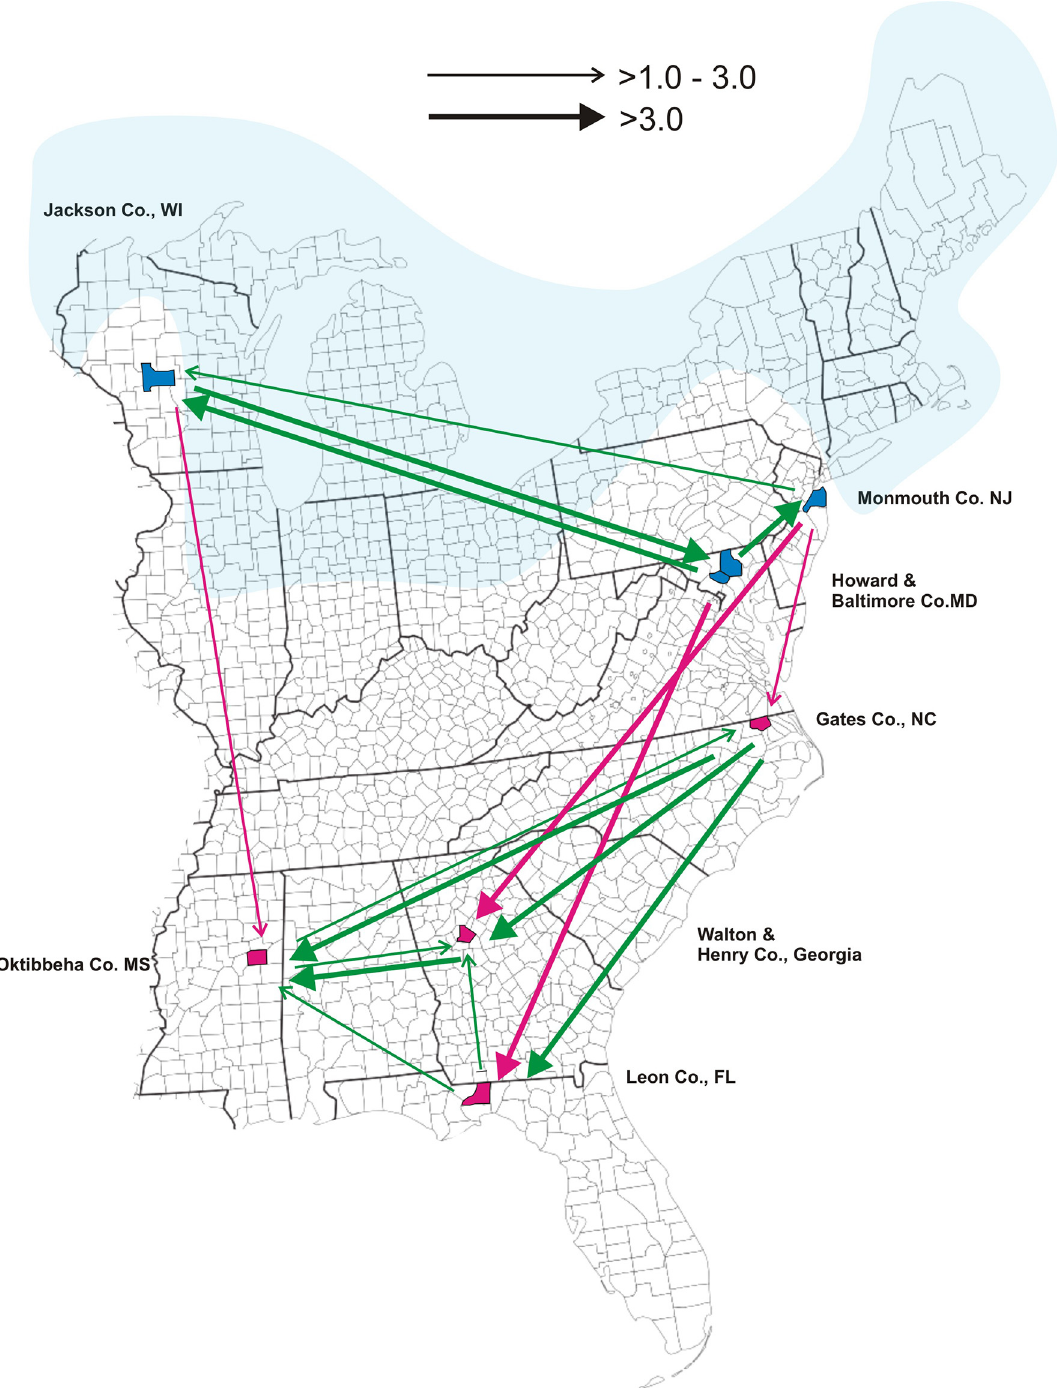
Fig 1. Locations of tick collections from Monmouth County, New Jersey, Jackson County, Wisconsin, Gates County, North Carolina, Howard and Baltimore Counties, Maryland, Oktibbeha County, Mississippi, Leon County, Florida and from Walton and Henry Counties, Georgia. The Laurentide Ice Sheet existed from 95,000 and 20,000 years before the present day. Its maximum intrusion is highlighted in blue. The arrows in the diagram indicate the rate and direction of gene flow among the seven locations as estimated by LAMARC. 4N e m values are displayed as arrows on the collecting site map (Fig 1) to indicate the direction of gene flow between two collections and relative rates of immigration. When 4N e m (cid:1) 1, no arrow was displayed, but when 1 < 4N e m (cid:1) 3.0 a thin open arrow is displayed. Thick open arrows indicate when 4N e m (cid:3) 3. Green arrows signify gene flow within the south or within the north while red arrows indicate north to south gene